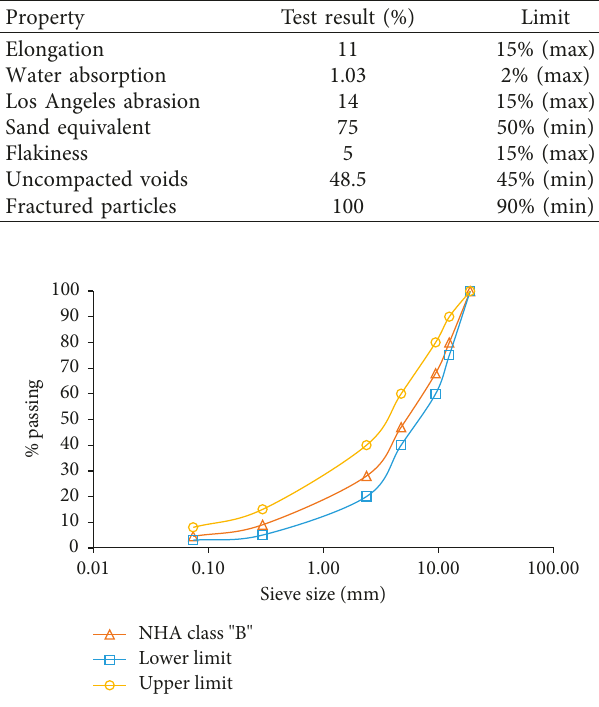
Figure 1: Gradation curve of aggregates used for asphalt